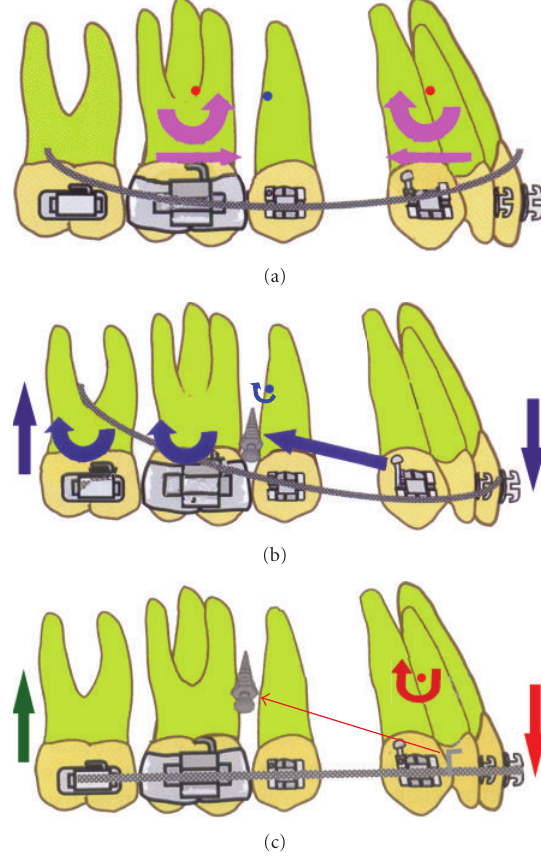
Figure 1: (a) E ff ect of space closure with conventional sliding mechanics without miniscrew. Anterior and posterior segments rotate around CR of each segment, archwire forced to bend near rotation of entire arch. These changes can easily be prevented with precurved archwires. (b) Retraction force from miniscrew anchorage with continuous archwire produces rotation of entire arch around Cres of dentition. (c) Rotation of anterior segment around Cres of anterior teeth.